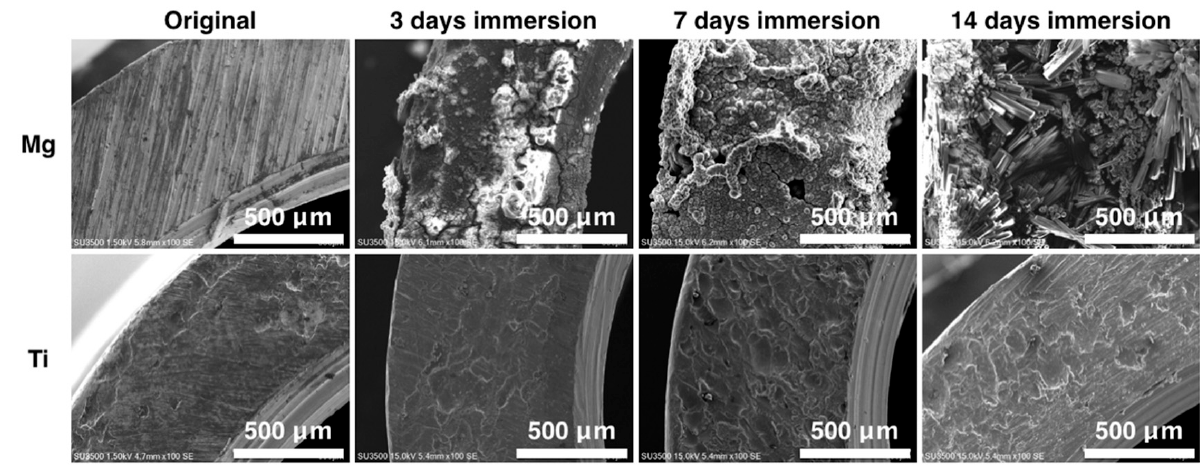
Figure 5. Surface morphology of magnesium and titanium rings after 3, 7 and 14 days of immersion in Hank’s solution.